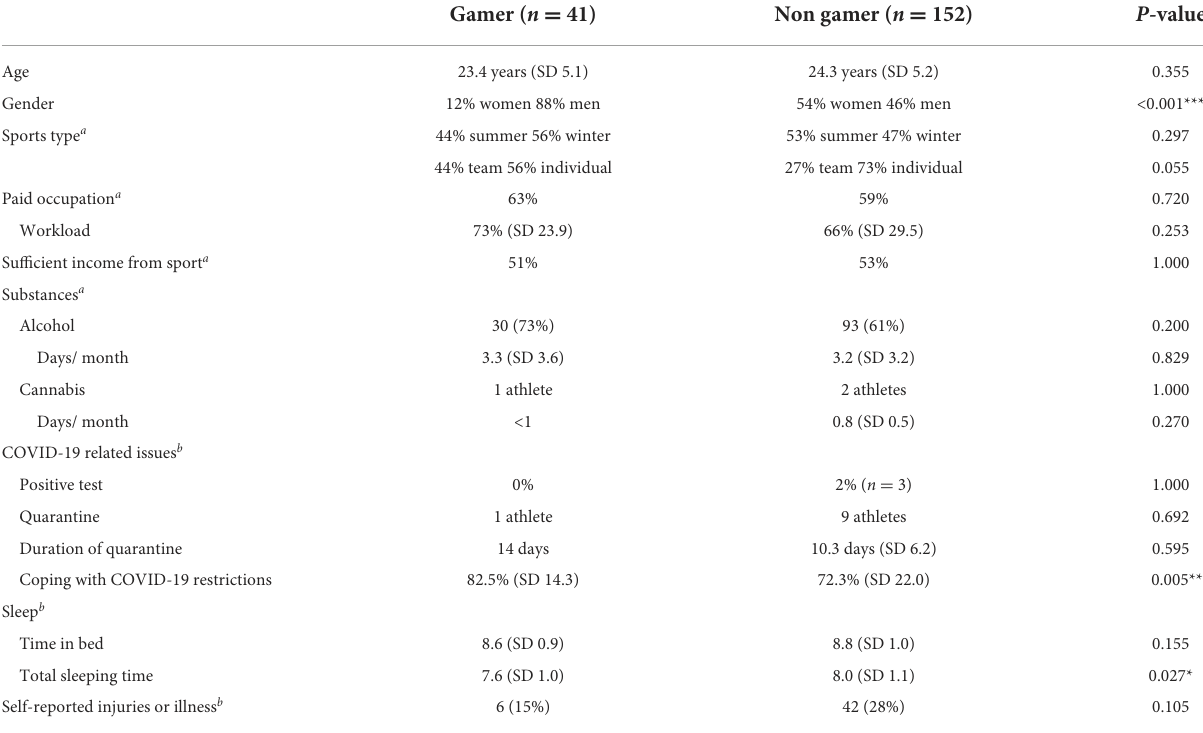
TABLE 1 Characteristics of professional athletes who game regularly compared to non gaming professional